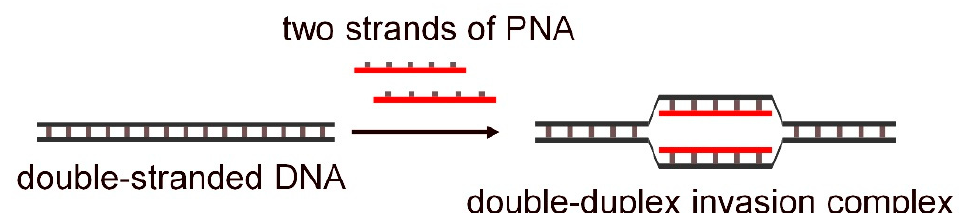
Figure 2. The dsDNA recognition by PNA via double-duplex invasion.